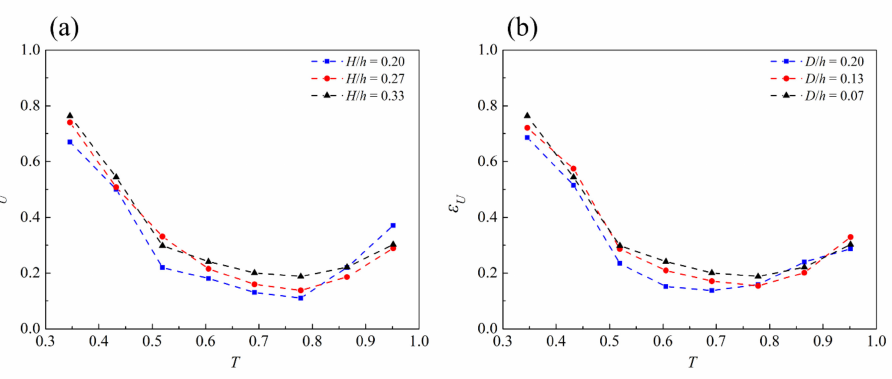
Figure 14. Deviation coefficients between measured velocities and Ritter’s solutions: ( a ) case 3, case 4, and case 5, D / h = 2/30; and ( b ) case 1, case 2, and case 3, H / h =